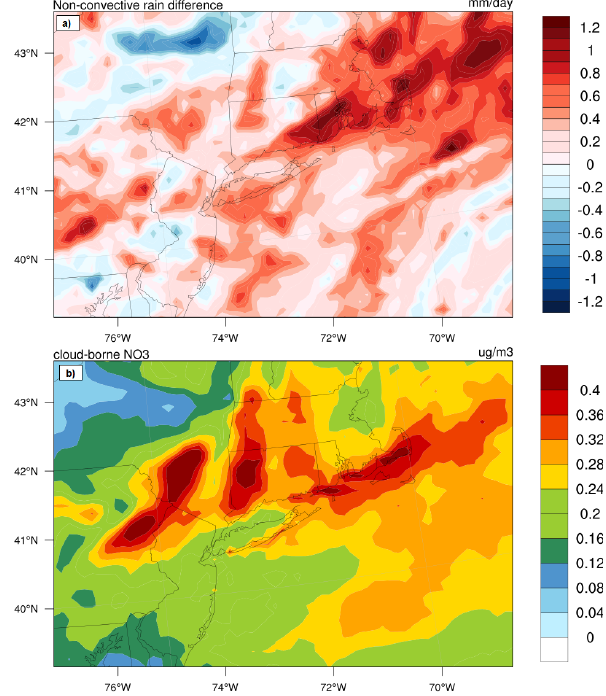
Figure 7. Spatial distributions of five month mean (April to August 2009) non-convective WRF/Chem-WRF rain difference (a) and the column integrated cloud-borne nitrate (b)